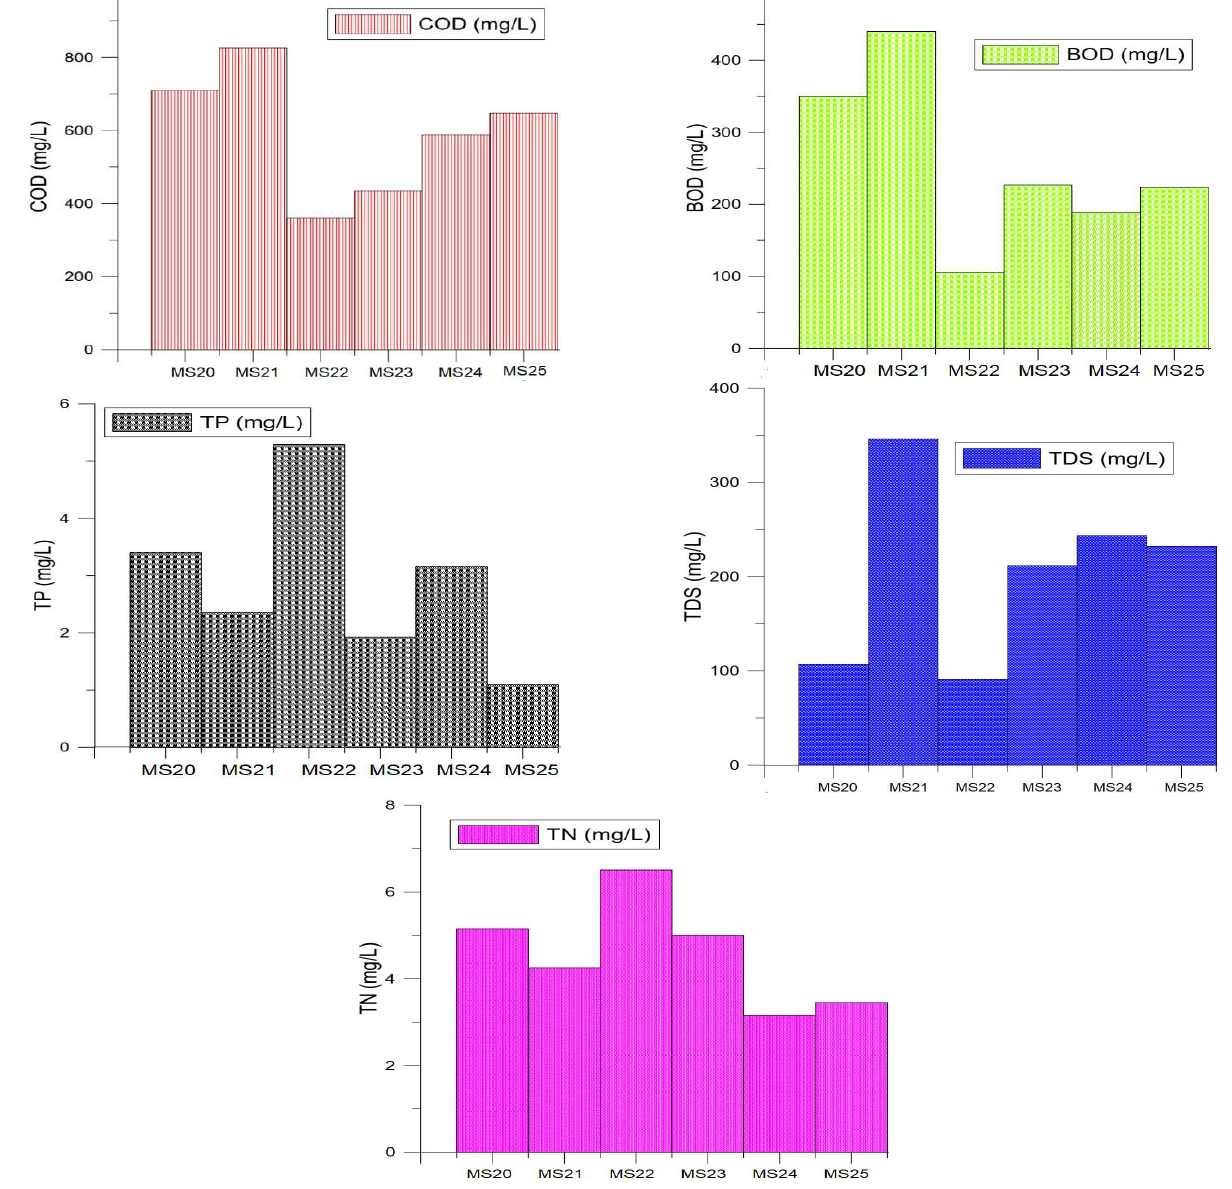
Figure 10. Selected physicochemical parameters concentrations (mg/L) in the stormwater samples collected over six monitoring stations from Hawassa City.